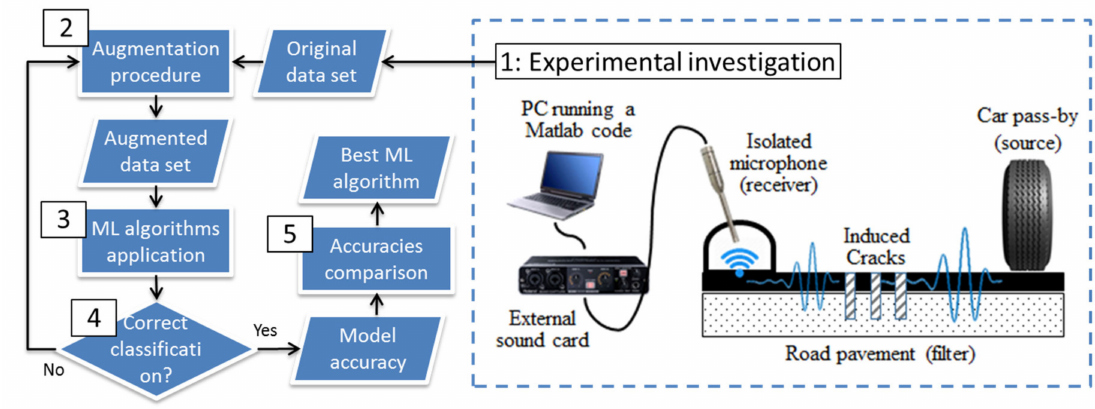
Figure 1. Framework of the